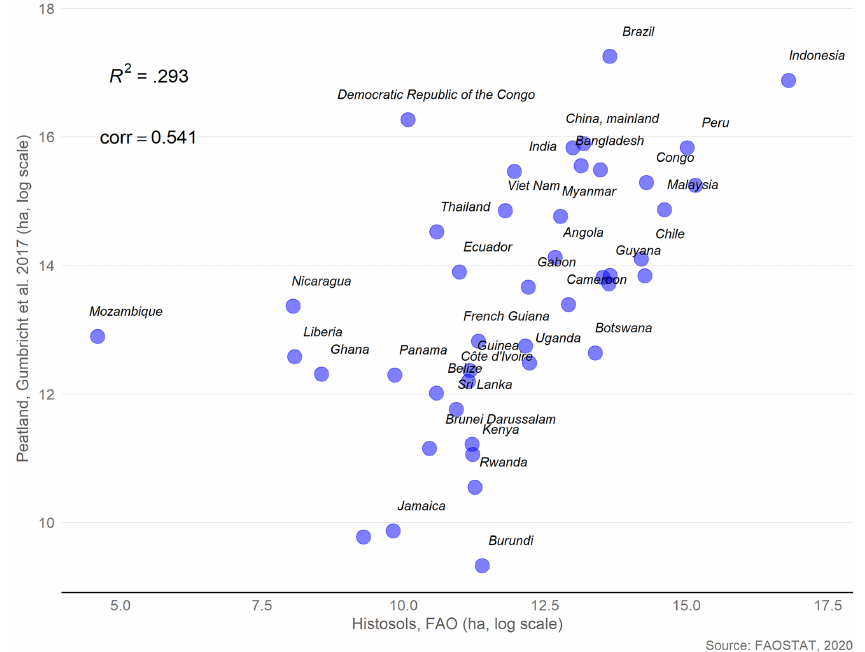
Figure 9. Scatterplot of area estimates for organic soils in published data (Gumbricht et al., 2017) and FAOSTAT. Data have been log- transformed to avoid dependence on a few large